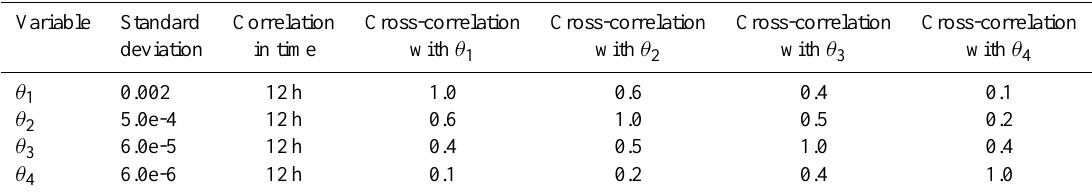
Table 2. Additive perturbation errors (same unit as volumetric water content) given to the four Noah soil moisture variables ( θ 1 , θ 2 , θ 3 , and θ 4 ) and their cross-correlations (the last four